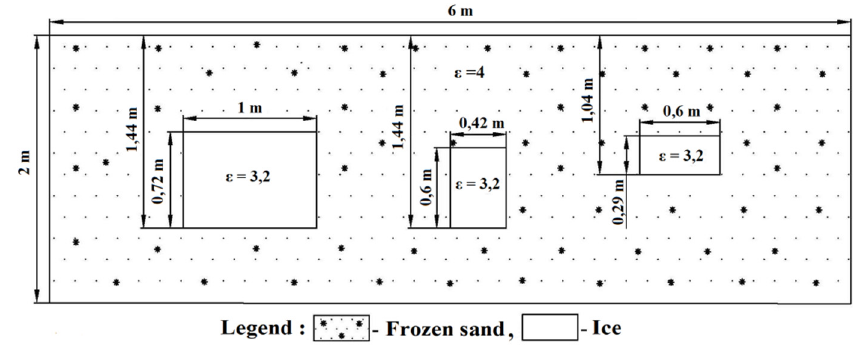
Figure 2. The scheme of a model of frozen rock mass with massive ice.